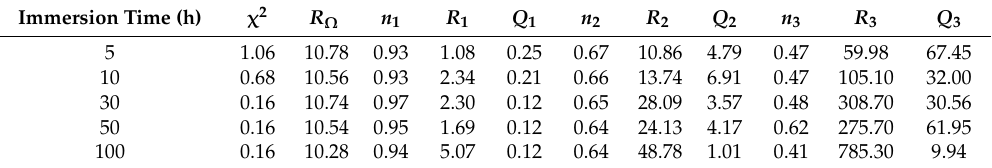
Table 1. Fitted EIS parameters for the copper samples after 5, 10, 30, 50, and 100 h of immersion in in Figure 6. Units: χ 2 ( × 10 − 3 ), R Ω ( Ω cm 2 ), R 1 , R 2 , and R 3 (k Ω cm 2 ), and Q ( µ S cm − 2 s n